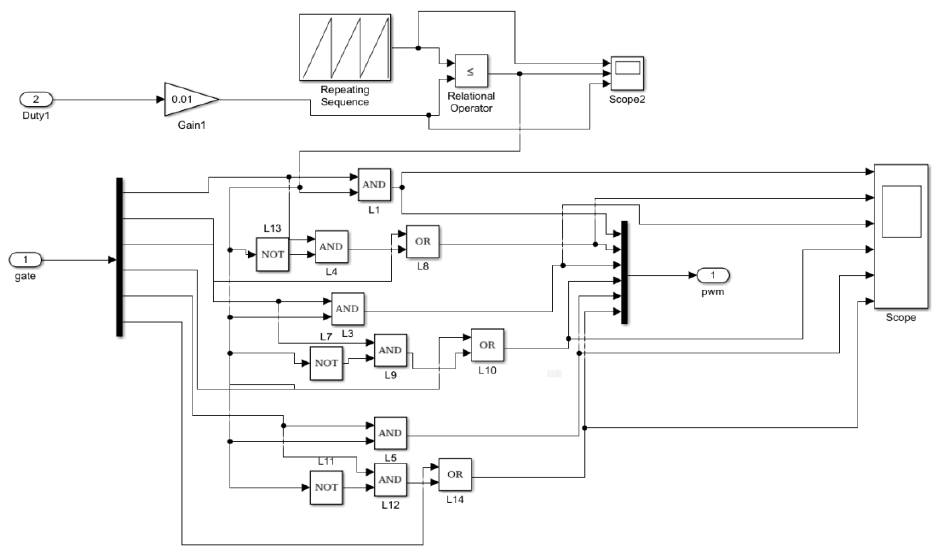
Figure 7. PWM Generation in PWM-PWM mode.